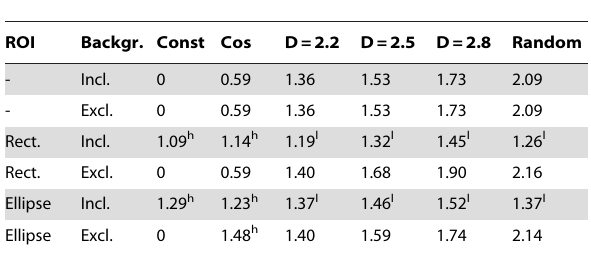
Table 1. ROI influences on Higuchi Dimension using projection method (i).